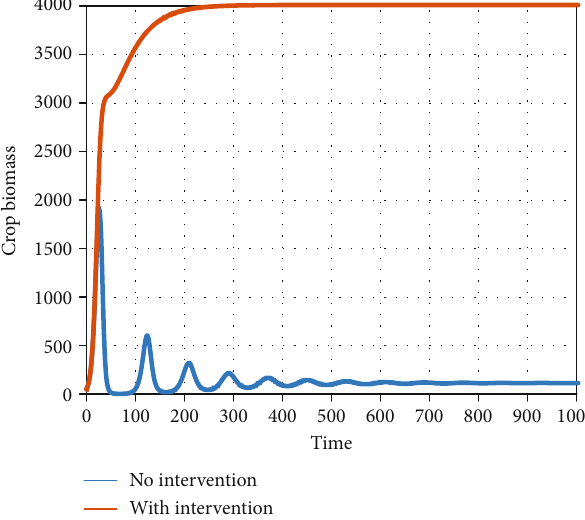
Figure 5: Impact of the proaction approach of early intervention on crop biomass. The simulation was conducted in the absence of intervention ( θ = θ = γ = γ = 0 ) and within early intervention 0 1 2 = 0 : 00025 , γ = 0 : 00225 , and only on hopper bands ( θ = 0 : 0025 , θ 0 1 γ = 0 2